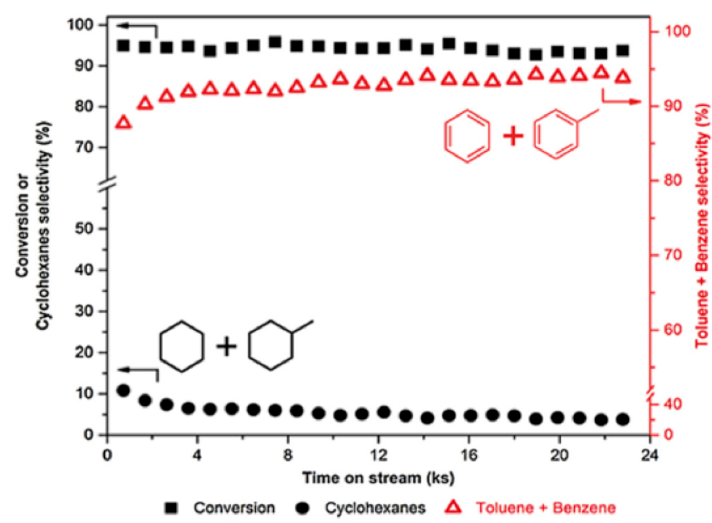
Figure 16. Conversion and selectivity to different products as a function of time on stream in HDO of a mixture of m ‐ cresol, anisole, dimethoxybenzene and guaiacol at 280 °C under 144 kPa over Mo 2 C catalyst [42].